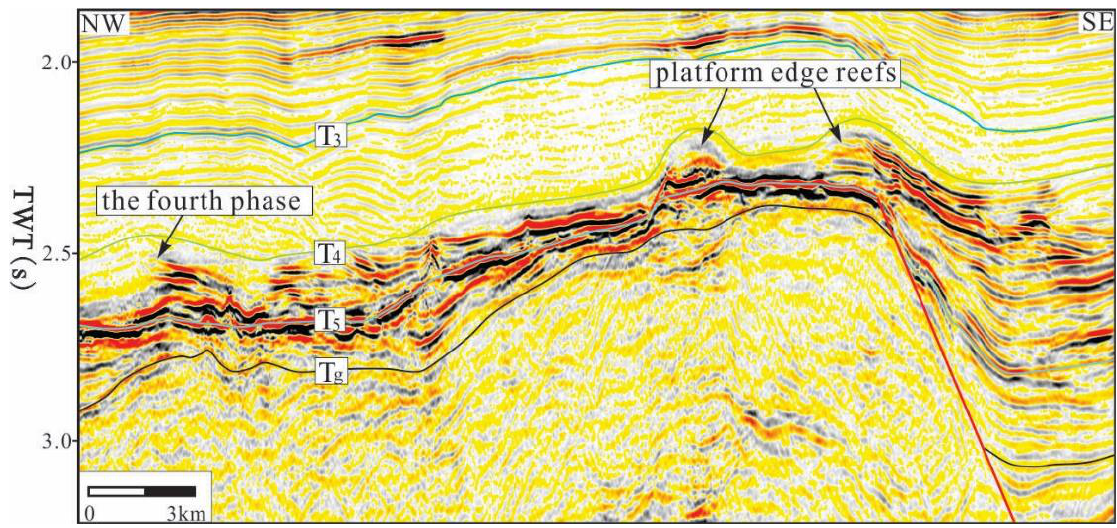
Figure 9. Seismic profile of the carbonate platform on the northern slope of the Guangle Uplift. The profile location is shown in Figure 1B.